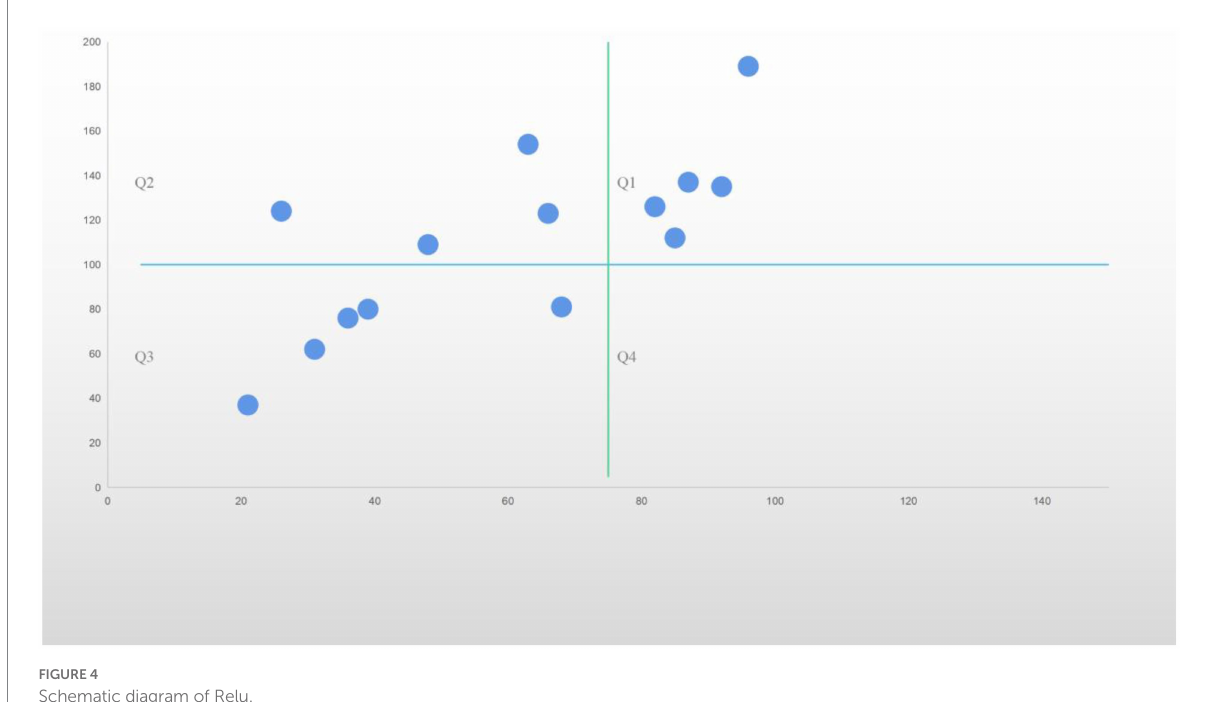
FIGURE 4 Schematic diagram of